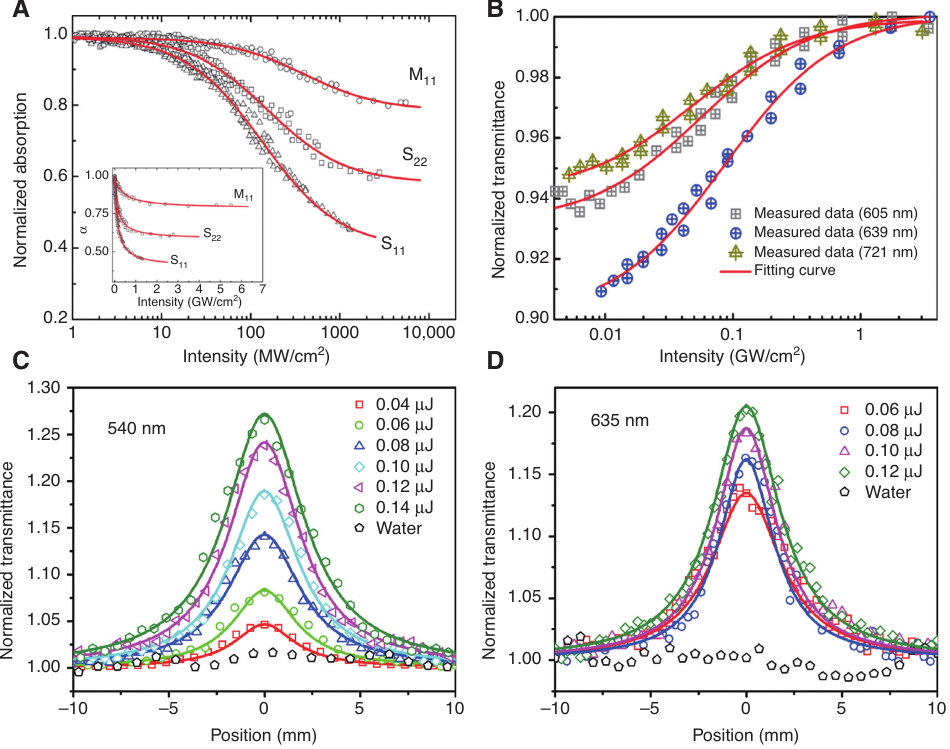
Figure 6: Nonlinear saturable absorption properties of nanomaterial SAs without a bandgap structure. (A) OA Z-scan results of SWNTs at 700 nm (M ), 1000 nm (S ), and 1800 nm (S ). (B) Normalized transmittance of Au NPs at 605, 639, and 11 22 11 721 nm. (C) and (D) are the OA Z-scan traces of the Au NRs at 540 and 635 nm. (A) Reproduced from Ref. [121], Copyright 2016, Royal Society of Chemistry. (B) Reprinted from Ref. [164], Copyright 2015, AIP Publishing LLC. (C) and (D) Adapted from Ref. [144], Copyright 2019, The Royal Society of